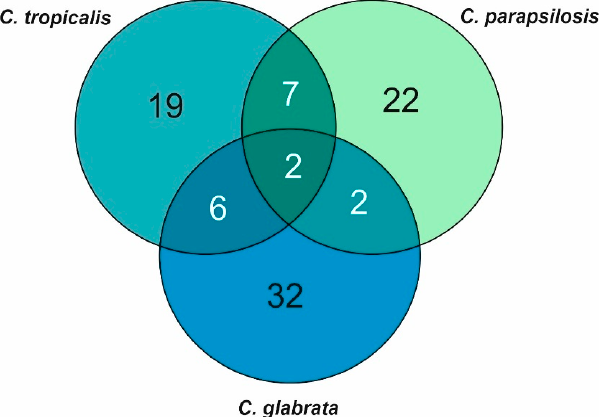
Figure 3. Numbers of specific and shared proteins among C. glabrata , C. parapsilosis and C. tropicalis